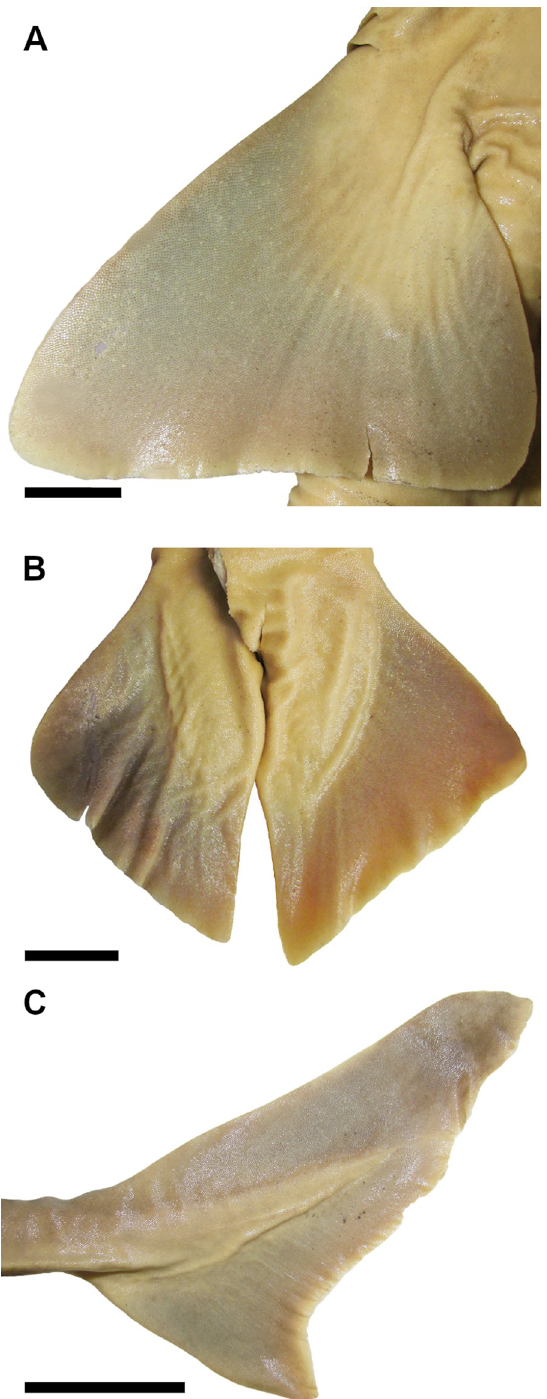
Fig 24. Pectoral (A), pelvic (B) and caudal (C) fins of the paratype of C . asper in ventral (A,B) and lateral views (C). A, B: BMNH 1972.10.10.3, adult female, 865 mm TL; C: BMNH 1972.10.10.1, adult male, 880 mm TL. Scale bars: 20 mm.